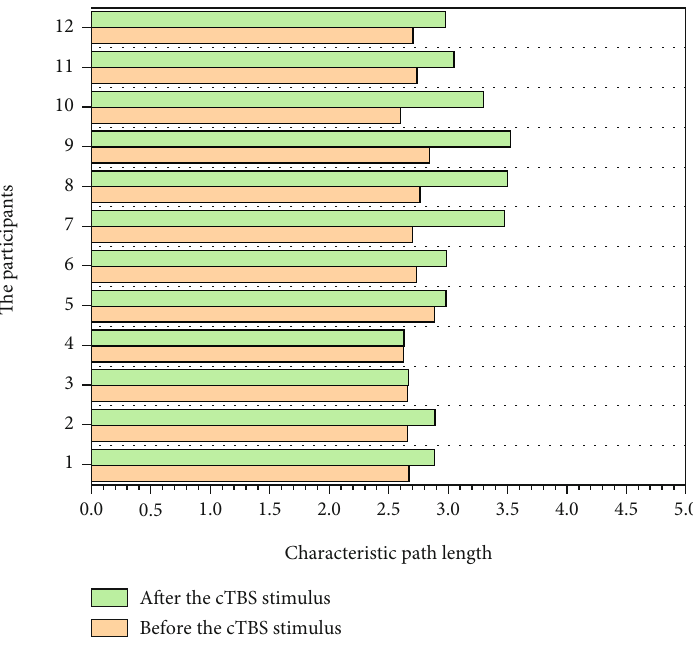
Figure 8: Network characteristic path length before and after cTBS